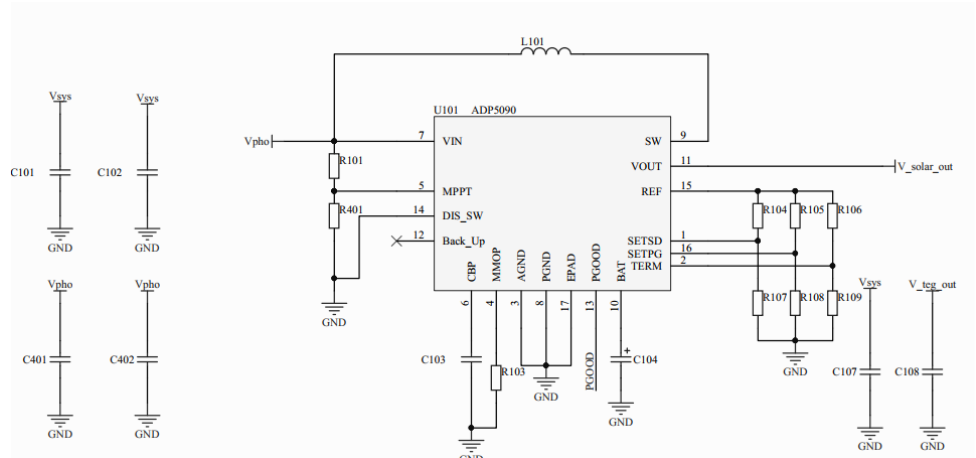
Figure 2. Scheme of the solar energy-harvesting circuit.